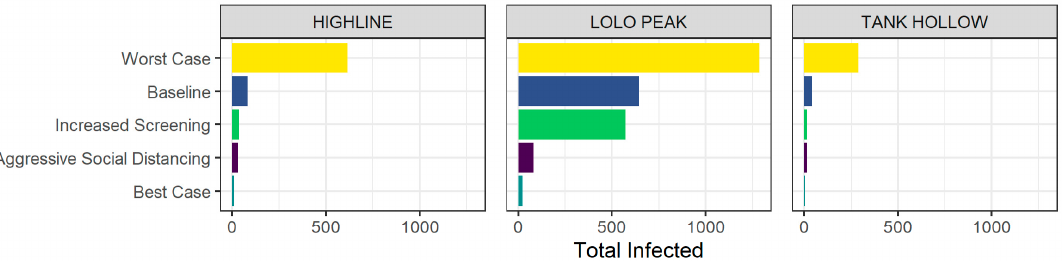
Figure 7. A comparison of the total of infected persons across fires and scenarios. Total infected for the best-case scenario is approximately 8, 21, and 4 individuals for the Highline, Lolo Peak, and Tank Hollow fires,